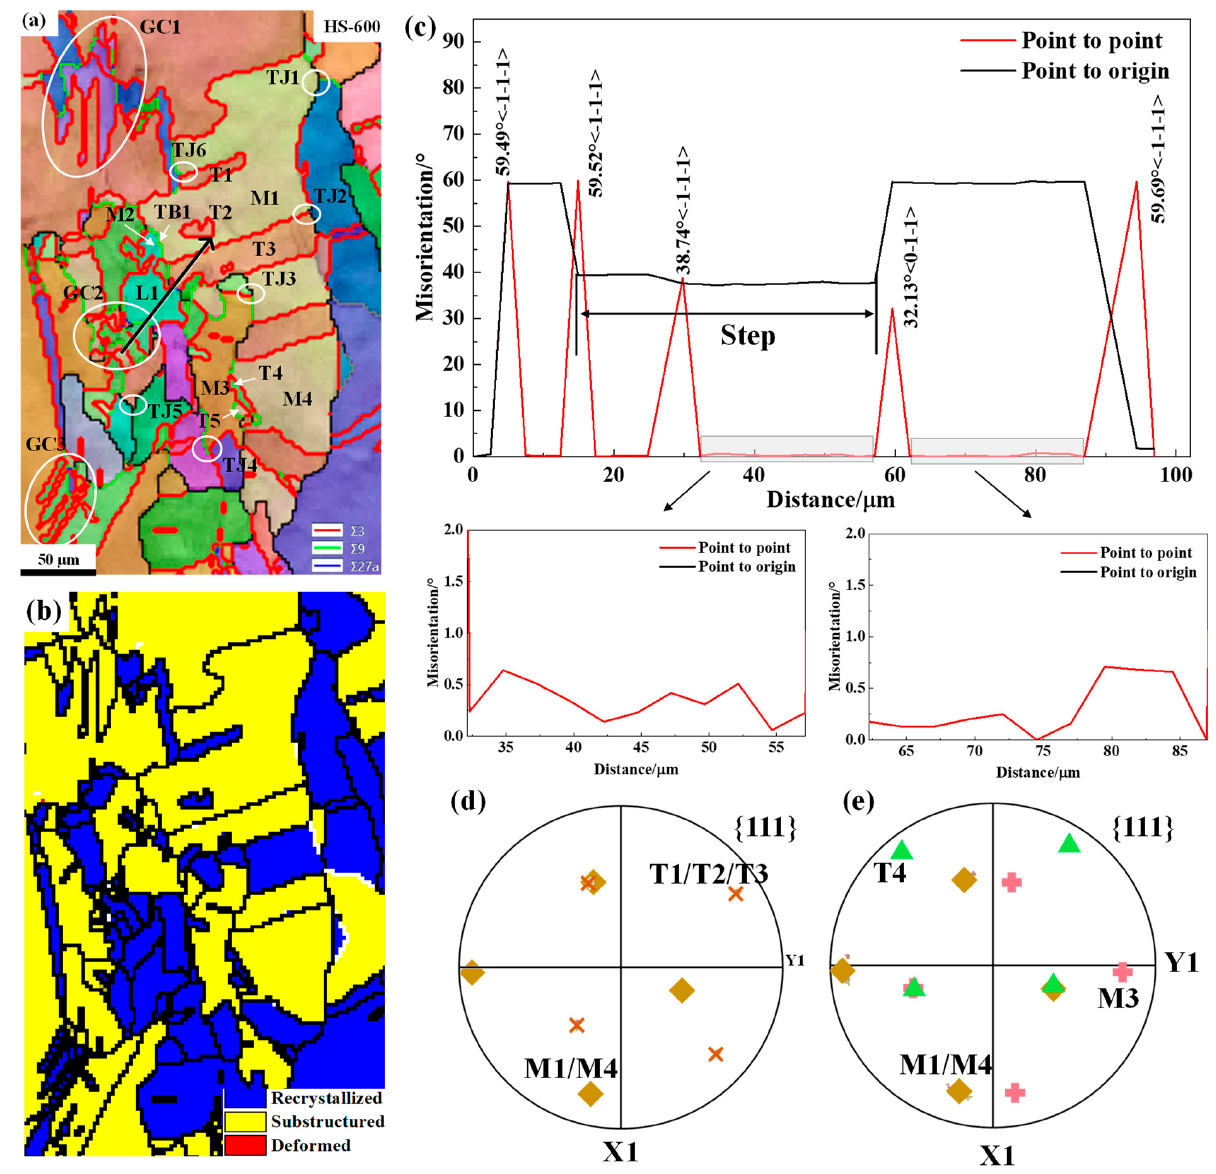
Figure 8. The partial enlarged detail of II in Figure 7a: ( a ) IPF map; ( b ) recrystallization map; ( c ) misorientation analysis along line L1 in Figure 8a; and ( d ) and ( e ) {111} pole figure of specific grains.